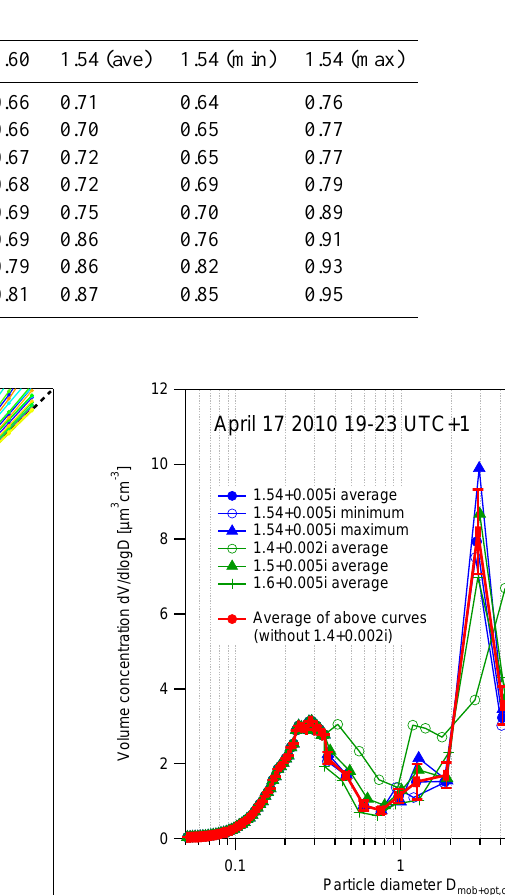
Table A1. Slopes of the linear correlation of PM 10 directly measured at the Jungfraujoch (betagauge method, time window 17 April 2010, 18:00–19 April 2010, 12:00UTC+1), versus PM 10 calculated from SMPS and OPC size distributions (see Sect. 3.1.3 for density assumptions) for all considered refractive indices. Columns represent different real parts and rows different imaginary parts, respectively. Orthogonal distance regression was applied for the calculations. Due to the wiggled shape of the curves shown in Fig. A1, the diameter correction is not bijective for a given refractive index. Therefore, minimal (min), geometric mean (ave) as well as maximal (max) correction functions are shown as example.